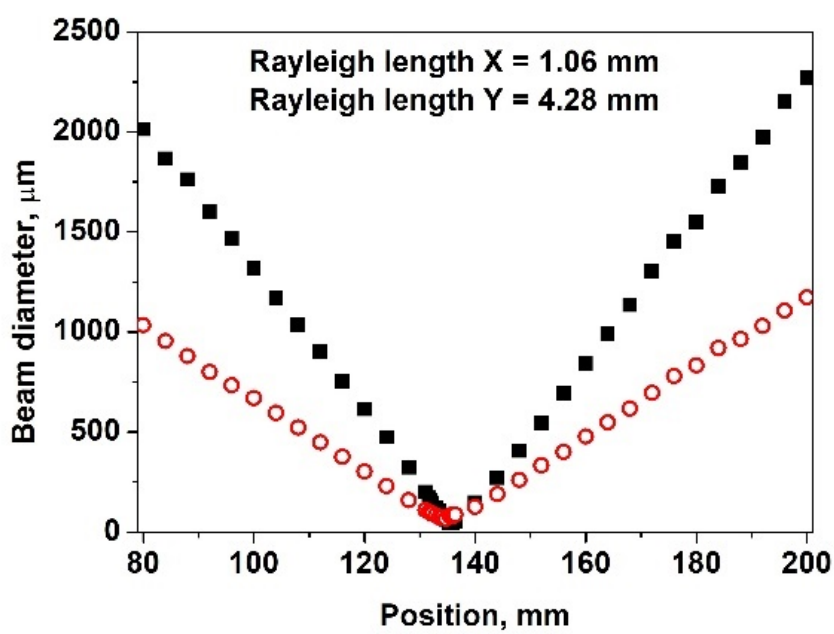
Figure 7. The result of M 2 -parameter measurement. Model: BC106N-VIS, serial number: M00417281, test method: full image, wavelength: 1030 nm; beam quality measurement: M 2 , beam diameter measure method: approximated ellipse at clip